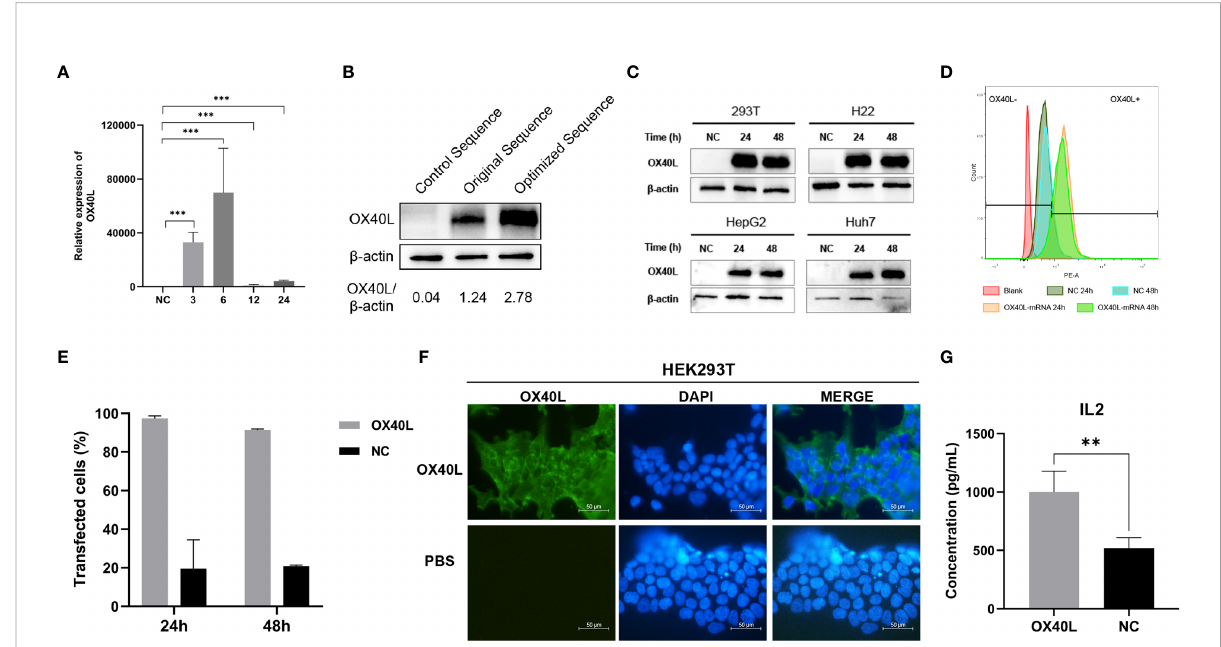
FIGURE 2 Identi fi cation, localization, and function of OX40L-mRNA protein. (A) Effect of OX40L mRNA-LNP according to RT-qPCR (B) Western blotting analysis of protein expression from the optimized and original sequences in HEK293T cells. (C) Western blotting analysis of optimized OX40L mRNA transfected into HCC cell lines. (D) Flow cytometry analysis of transfection ef fi ciency in HEK293T cells at 24 h and 48 h. (E) Quantitative analysis of (C) . (F) Immuno fl uorescence images of transfected HEK293T cells (scale bars: 100 m m). (G) ELISA of the supernatant IL2 levels in cocultures of lymphocytes with OX40L mRNA transfected Hep3B cells. Statistical signi fi cance was calculated via t test. ** P < 0.01; ***P <